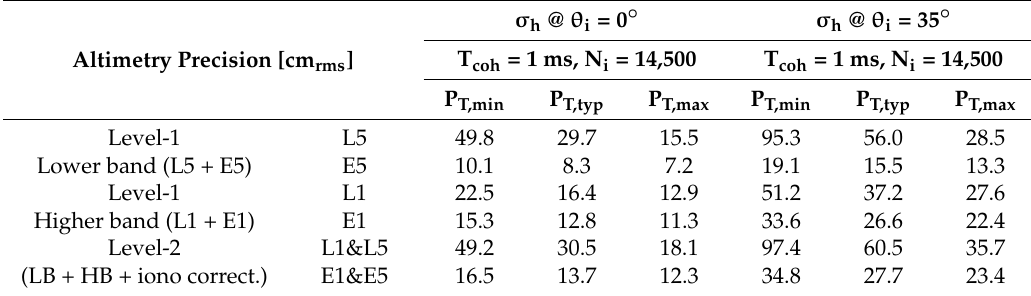
σ θ i = 0 ◦ σ θ i = 35 ◦ h @ h @